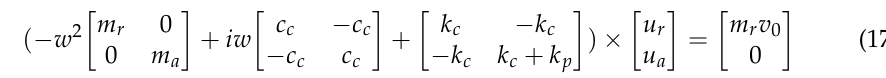
When the ram hits the surface of the anvil, the resistance of the soil slows down the movement of the pile and causes the ram to rebound. Since the anvil surface force is computed by assuming a linear elastic model, tractions are generated at the moment of the ram’s rebound. Obviously, this effect is caused by the weakness of the models, which, due to their elastic nature, cannot represent the contact loss between bodies. In order to prevent these tractions and, consequently, the occurrence of negative forces, the force of the anvil surface in the time domain is truncated, as illustrated in Figure 4 for a generic case.